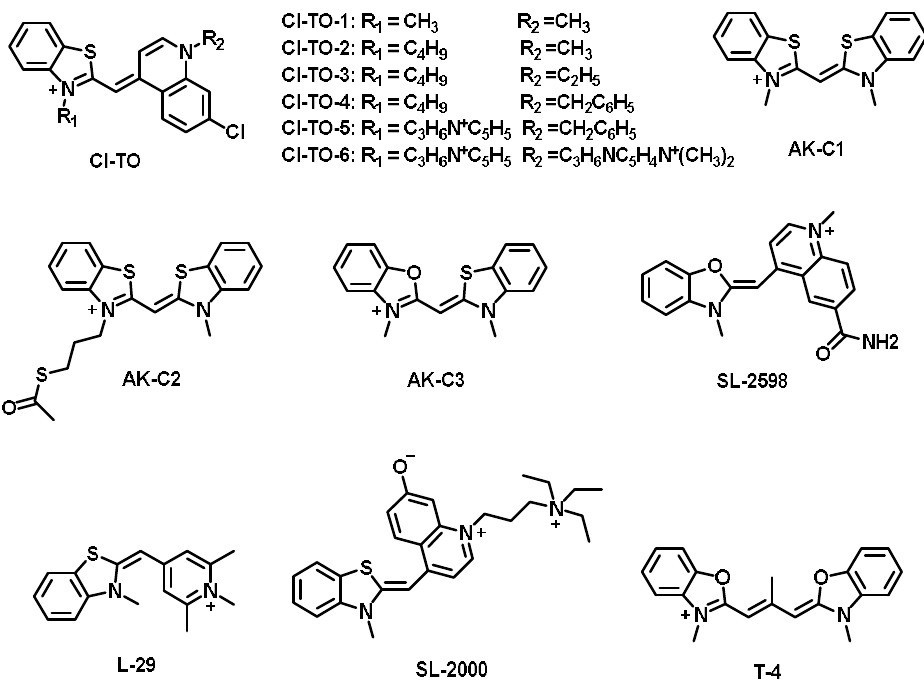
Figure 8. The chemical structures of Cl-TO, AK-C1, AK-C2, AK-C3, SL-2598, L-29, SL-2000 and T-